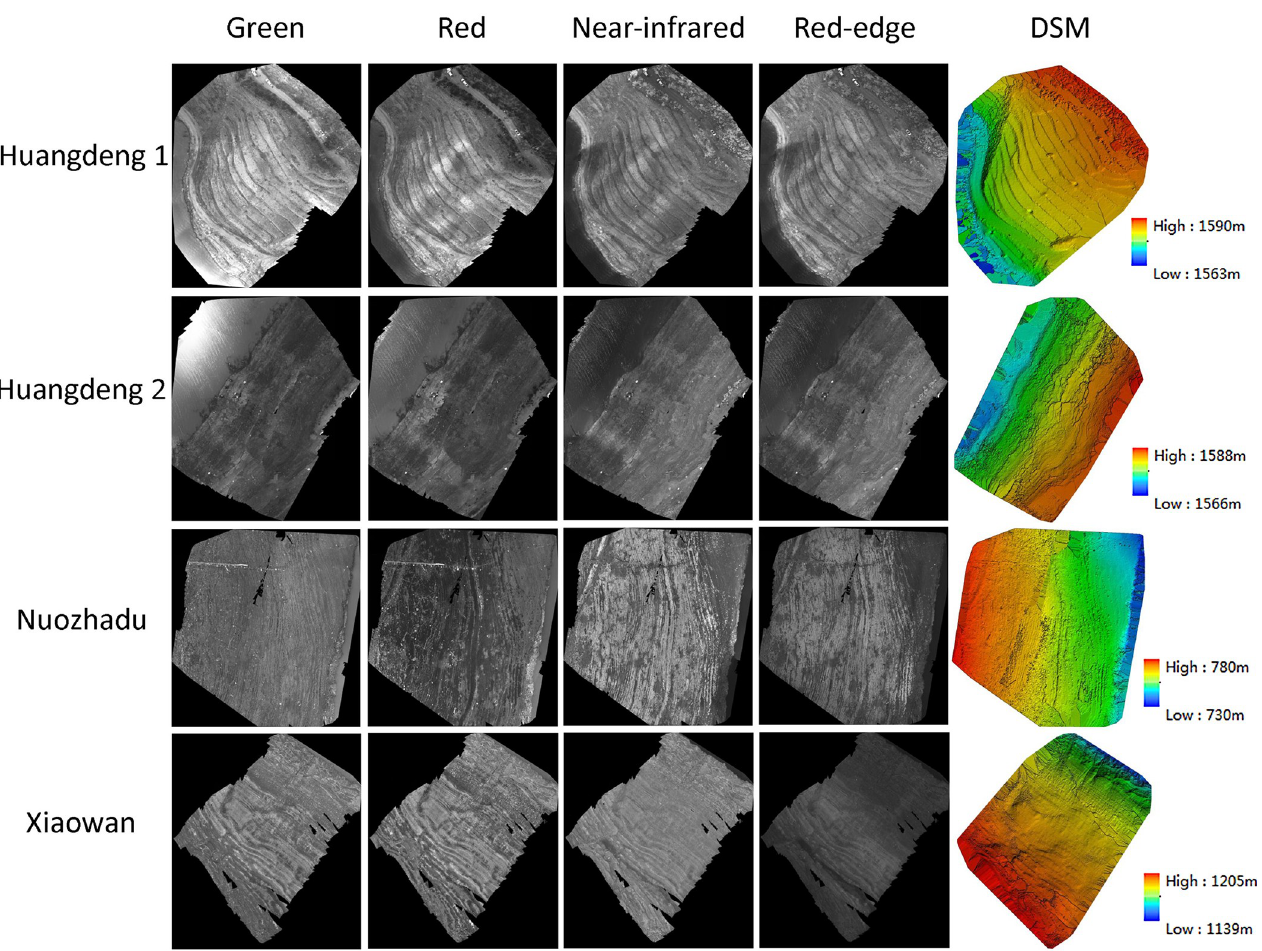
Fig 3. The digital orthophoto maps and digital surface models of the study areas.